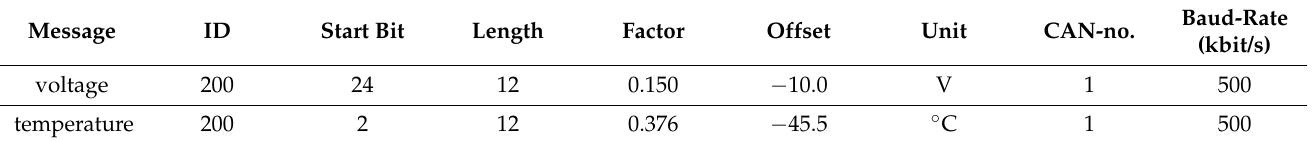
Table 3. Model-specific information needed to decode raw